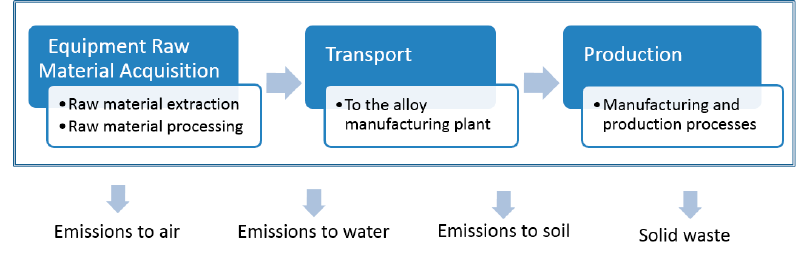
Figure 1. System boundaries.